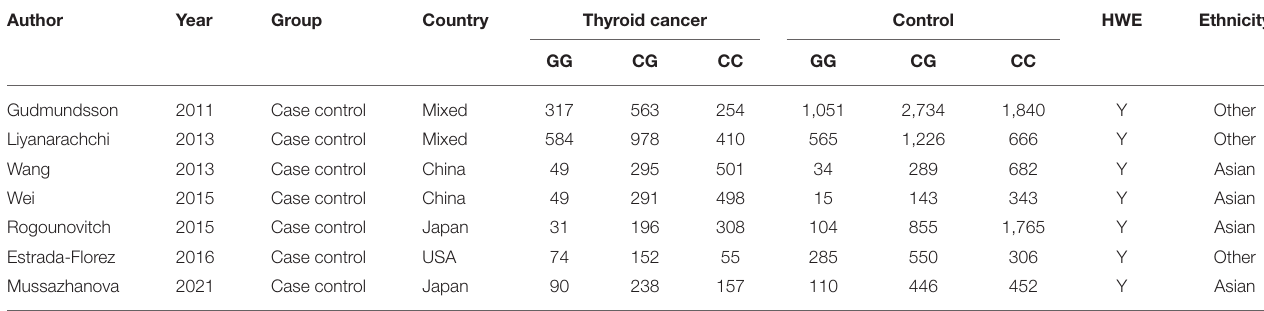
TABLE 1 | Characteristics of included studies in the